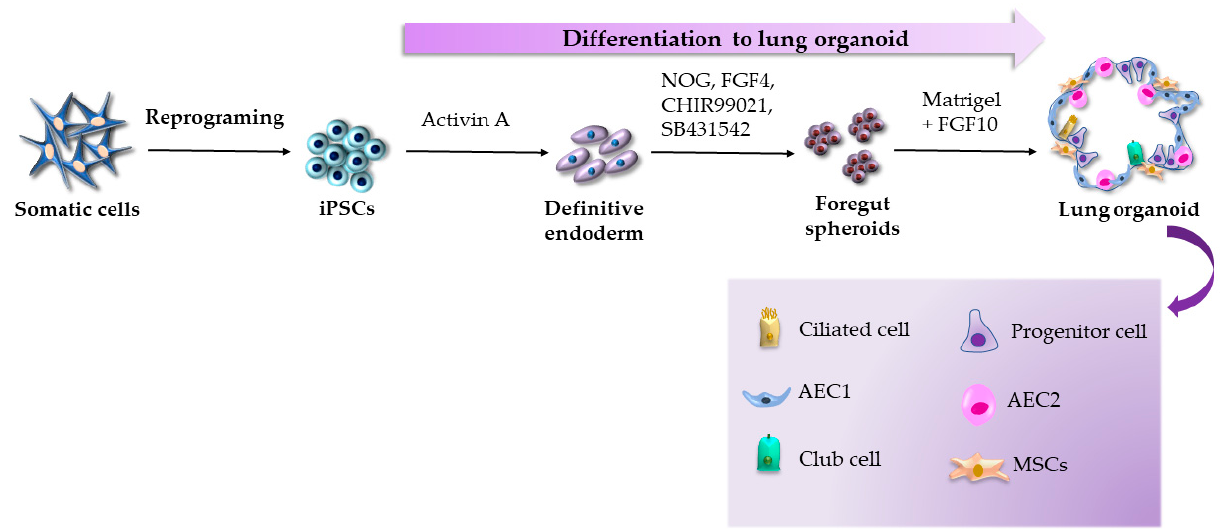
Figure 1. Generation of lung organoids according to the protocol by Dye et al. [43].